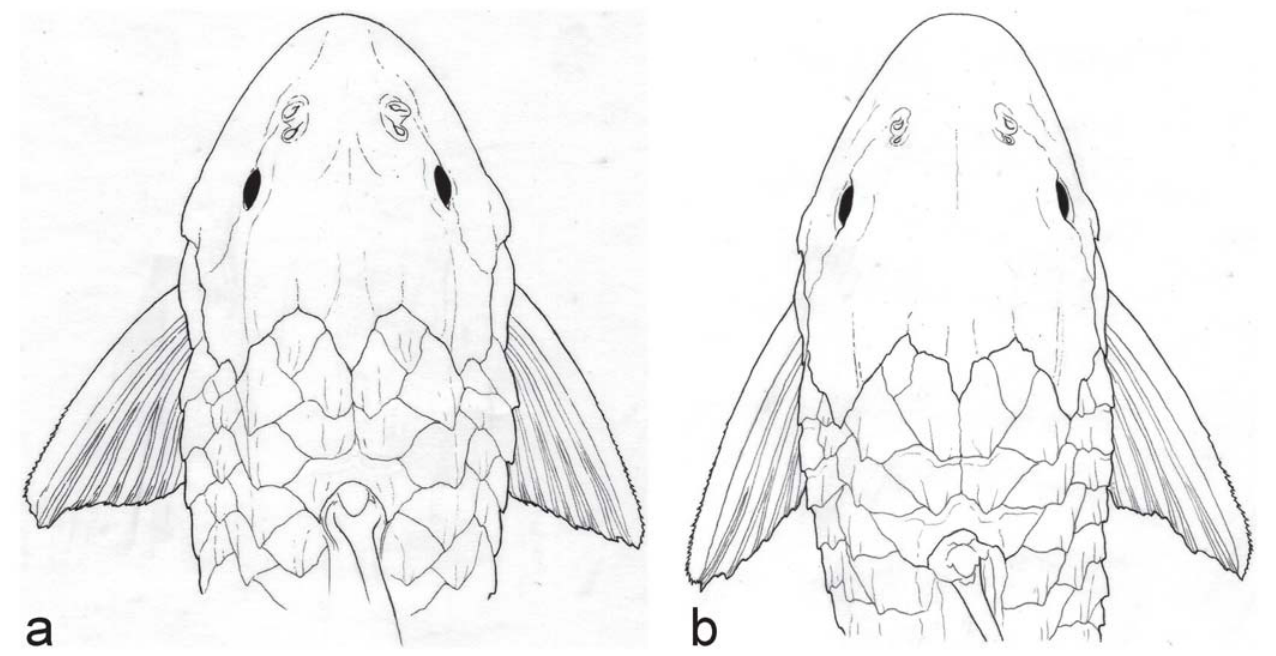
Fig. 3. Dorsal profiles of snouts of a. Pterygoplichthys punctatus , UF 148742, 160.1 mm SL and b. P. zuliaensis , AUM 22586, 222.0 mm